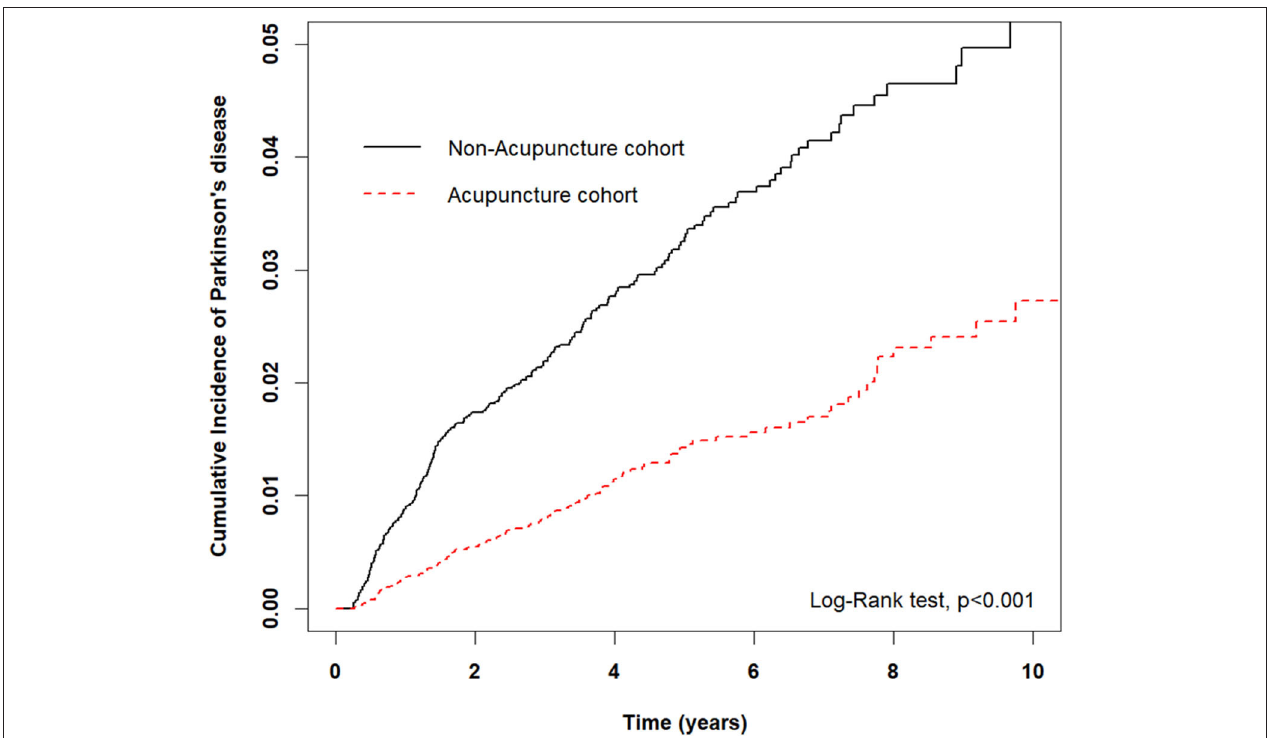
FIGURE 2 | Cumulative incidence of PD between the acupuncture and non-acupuncture cohorts. The cumulative incidence of PD in the acupuncture cohort was significantly lower than that in the non-acupuncture cohort (log-rank test, p <